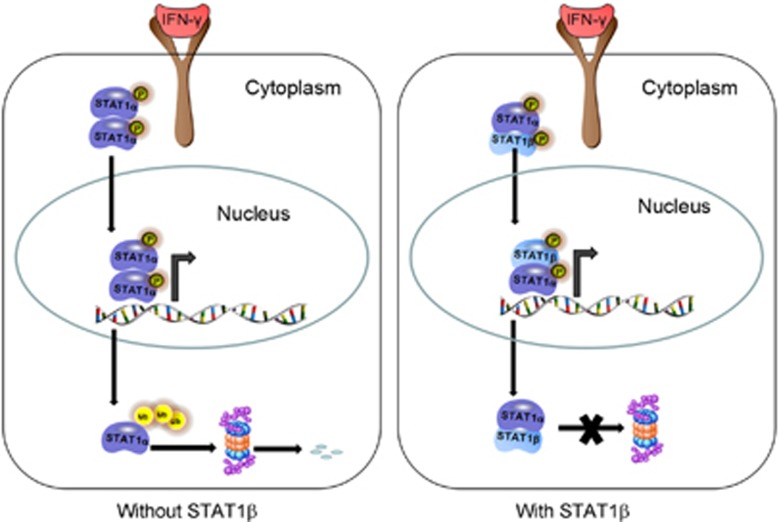
Schematic diagram showing STAT1β interacts with STAT1α. Upon IFN-γ stimulation, STAT1 can form three different dimers: α:α and β:β homodimers and α:β heterdimers. Dimers can be phosphorylated followed by translocation into the nucleus. Once STAT1 is released from the target gene promoter, it returns to the cytoplasm and is degraded by the proteasome. However, the STAT1β can bind to STAT1α to protect STAT1α from degradation, resulting in prolongation of the half-life of STAT1α and a concomitant increase in transcription activity